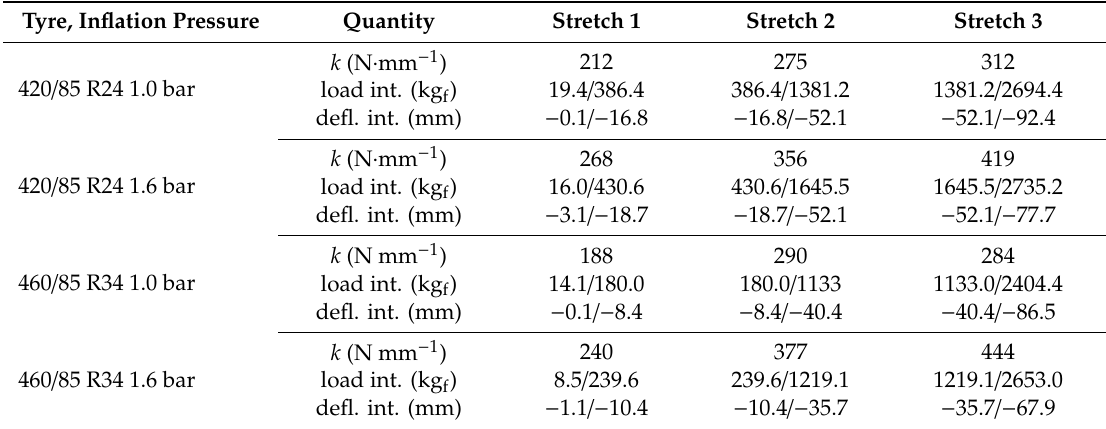
Table 2. Values of the elastic coe ffi cients in the three stretches of a loading curve in the two experimental trials for a 420 / 85 R24 tyre inflated with an initial pressure of 1.0 bar.